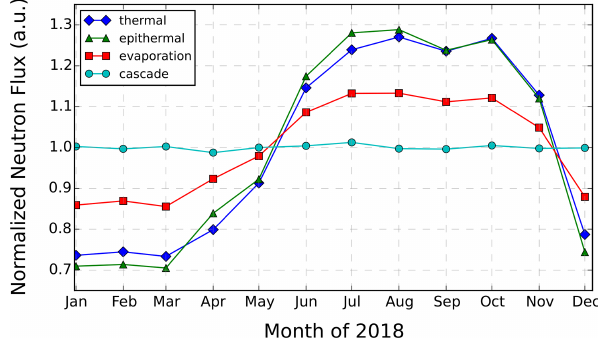
Figure 5. Monthly averaged neutron flux in 2018 at UFS Zugspitze, deduced from ERBSS neutron flux spectra for four energy regions (thermal: E < 0 . 4eV; epithermal: 0.4eV ≤ E < 100keV; evapora- tion: 100keV ≤ E < 20MeV; cascade: E ≥ 20MeV) normalized to annual mean